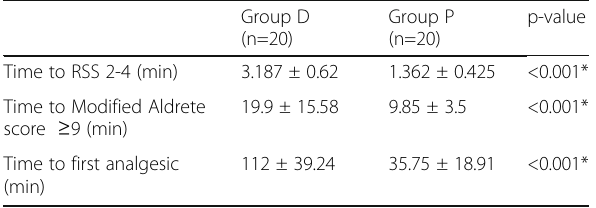
Table 2 Time to RSS 2-4, Modified Aldrete score ≥ 9 and first analgesic